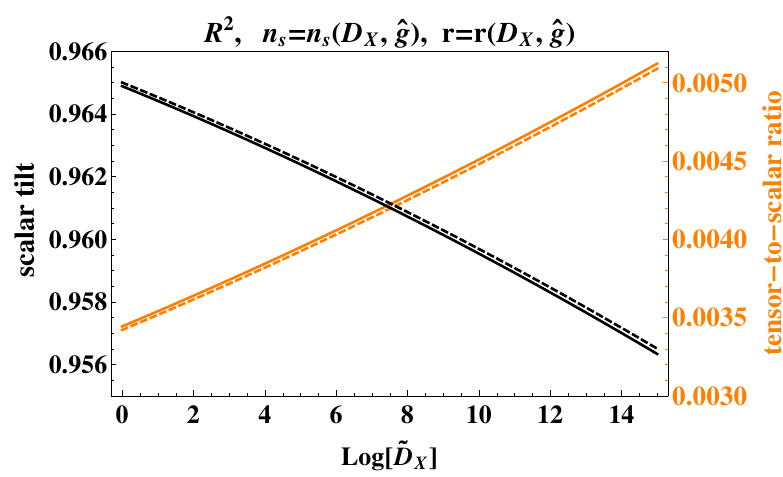
Figure 6 . The scalar tilt (in black) and tensor-to-scalar ratio (in orange) values when post- in(cid:13)ationary dilution is considered for the Starobinsky R 2 in(cid:13)ation model. The solid line corresponds to a change of factor 10 in the number of e(cid:11)ective degrees of freedom in the energy density at the times T dom and T dec , i.e. g (cid:3) ( T dom ) = 10 g (cid:3) ( T dec ), and the dashed line corresponds to no X X X X